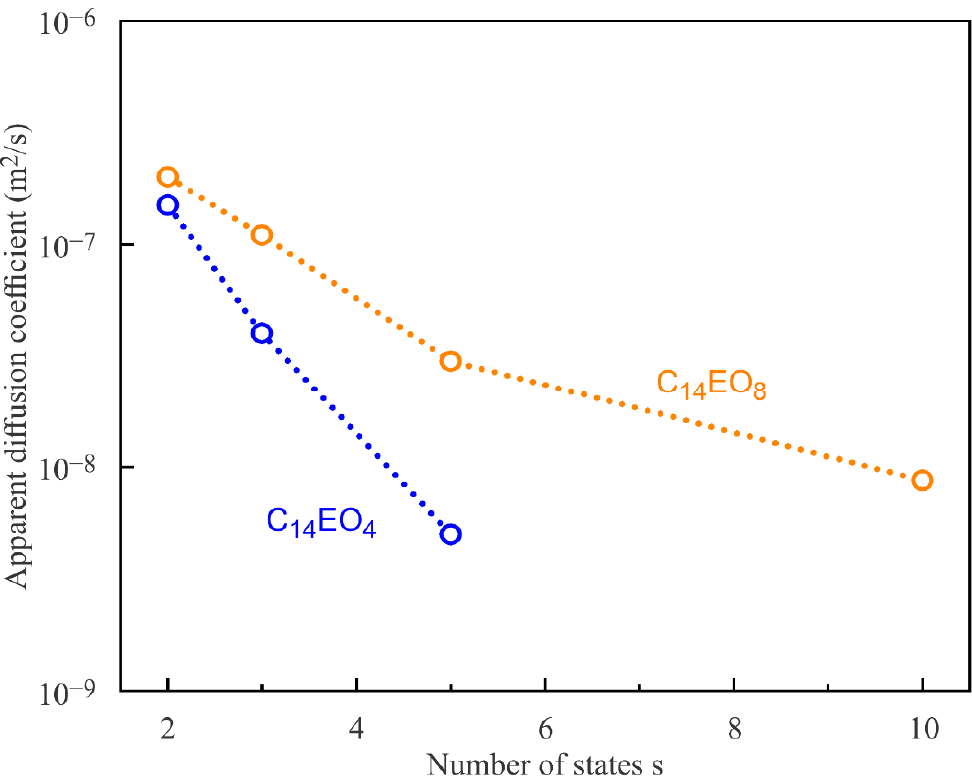
Figure 10. Dependence of optimized value of the apparent diffusion coefficient on the number of states. For details, see text.